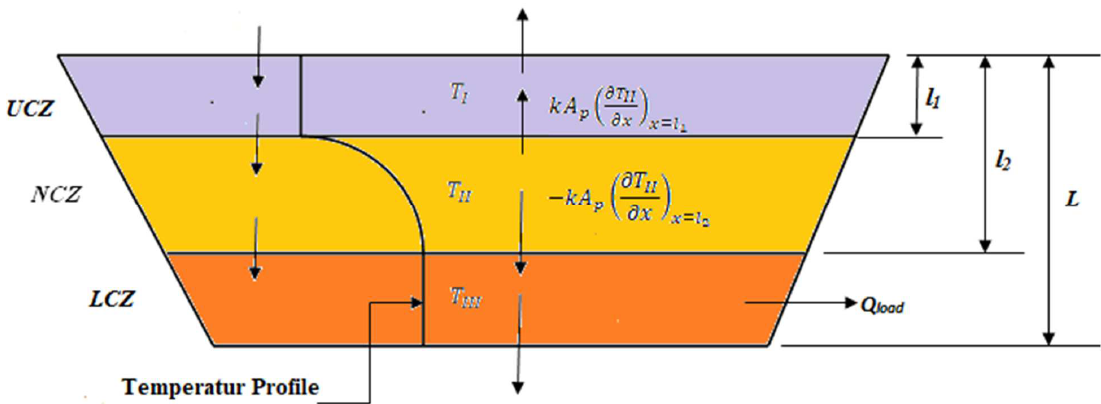
Figure 2. Energy flows of the various zones of a typical salinity gradient solar pond.